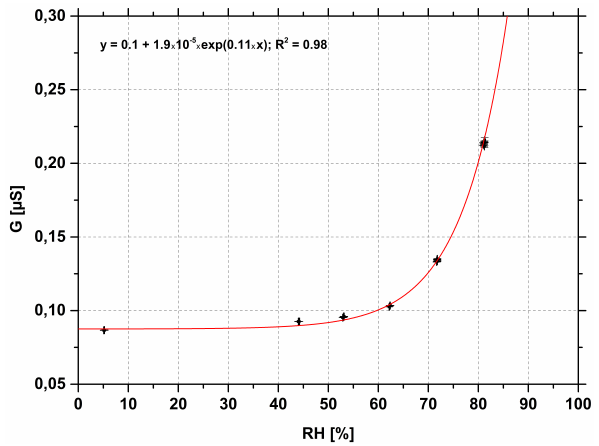
Figure 14. Relationship between relative humidity and electrical leaf surface conductance.